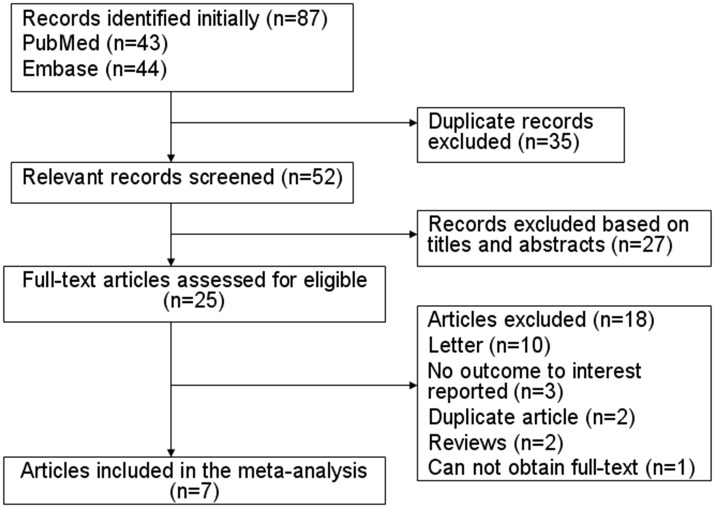
Flow chart of identification of eligible studies to final inclusion.